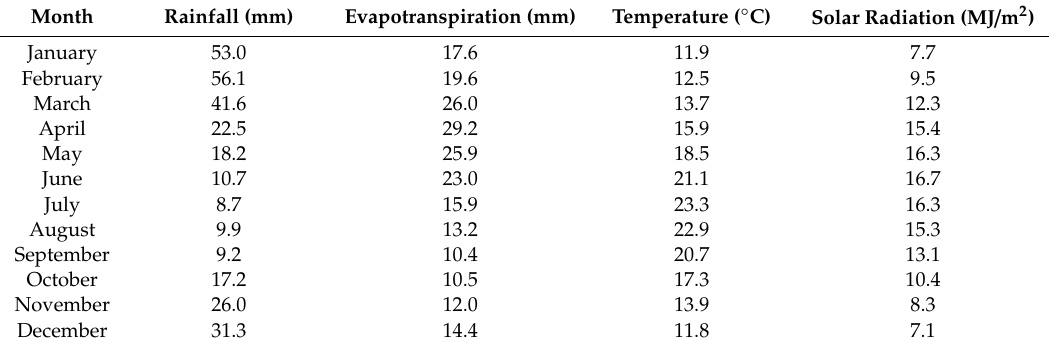
Table 8. Average Multi-annual Monthly Results of Precipitation, Evapotranspiration, Temperature, and Radiation for the